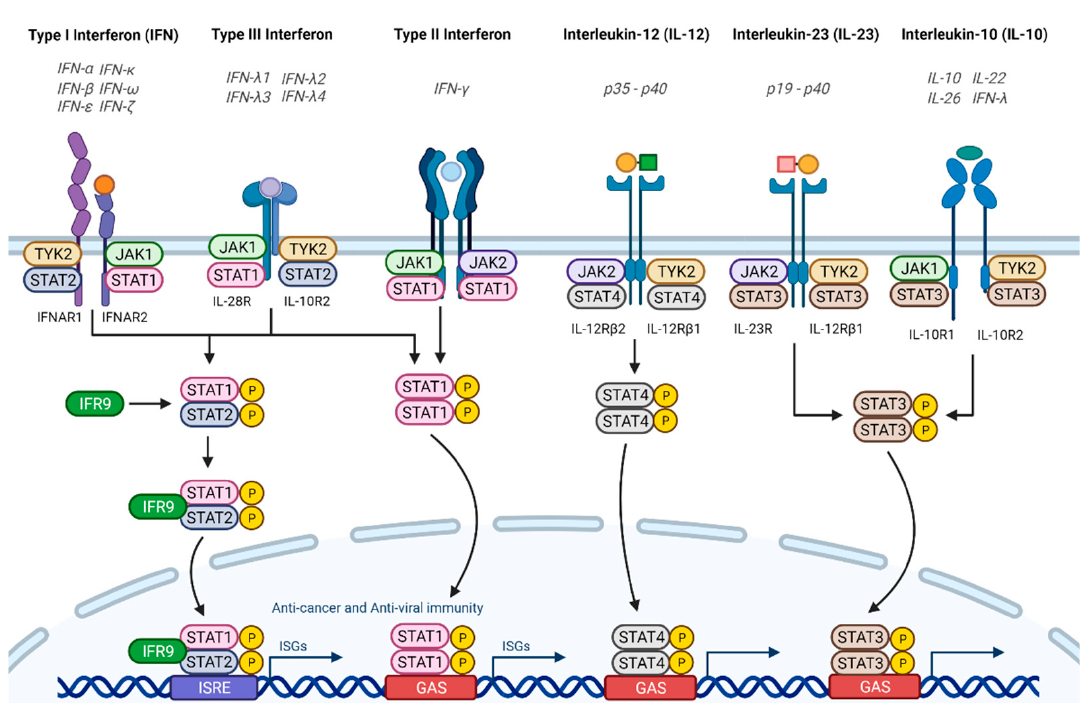
Figure 2. Overview of TYK2 signaling pathways. TYK2 and JAK1/2 interact with cytokine receptors to transduce cytokine signaling through activation of STATs and induction of target gene expression. Cytokine ligands, e.g., interferons (IFN) and interleukins (IL), bind to their respective receptors, leading to auto- or trans-phosphorylation of JAKs/TYK2 and receptor phosphorylation. Signal transducers and activators of transcription (STAT) are recruited and phosphorylated. Activated STATs then homo- or hetero-dimerize and are translocated to the nucleus, where STAT dimers bind to IFN-stimulated response elements (ISRE) or interferon- γ activated sequences (GAS) promoter elements to induce transcription of target genes. Downstream of Type I/III IFNs, STAT1/2 complex with the cofactor interferon regulatory factor 9 (IRF9). Illustration created with